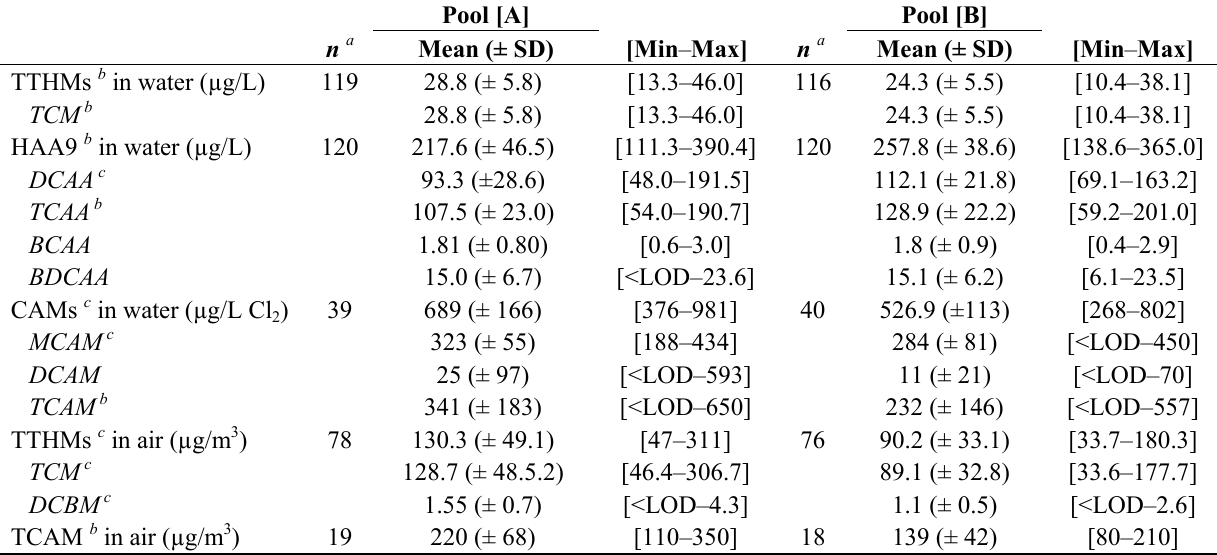
Table 2. DBP concentrations in pool water and air of [A] and [B] (all samples).